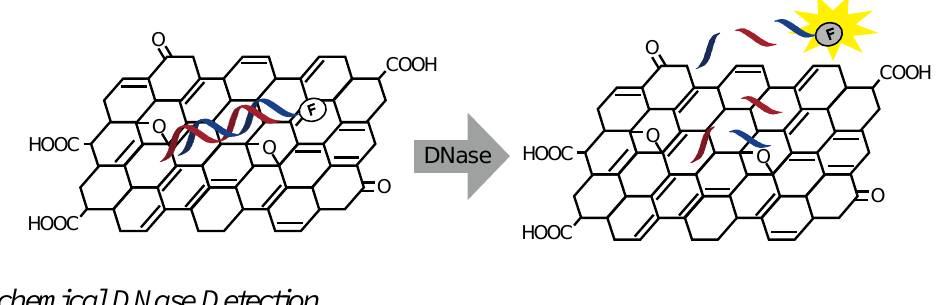
Figure 2. DNase I detection based on dequenching of fluorescence dye-labeled DNA duplexes on a GO